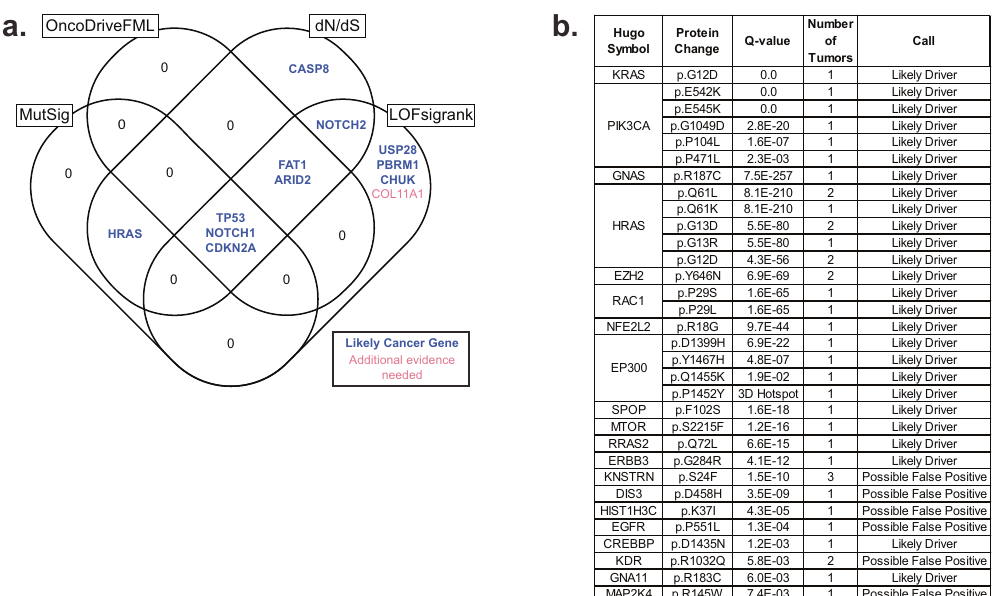
Fig. 2 Nomination of cancer genes in cutaneous squamous cell carcinoma. a A Venn diagram depicting nominated cancer genes from four separate cancer gene discovery programs, each designed to identify genes under positive selection in cancer. The set of candidate genes were further curated, as described, to nominate candidates for which additional evidence is warranted (red text) or not (blue text). b A list of mutations in our study that overlap mutations in the cancerhotspots.org database. Mutations are grouped by gene and ordered by their q values (lowest to highest). These mutations were also curated, as described, to nominate candidates for which additional evidence is warranted (Possible False Positive) or not (Likely